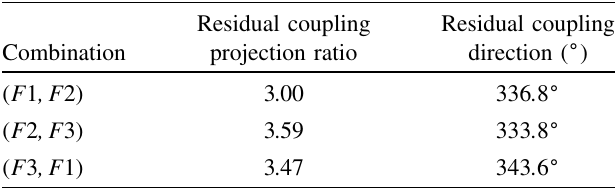
TABLE II. Residual coupling from